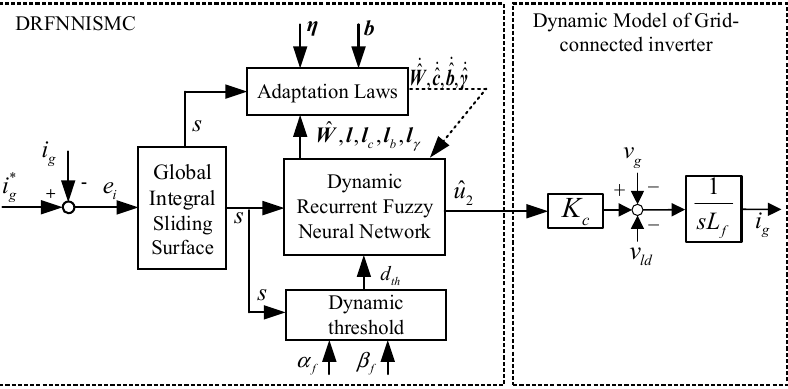
Figure 2. Block diagram of DRFNNISMC framework.